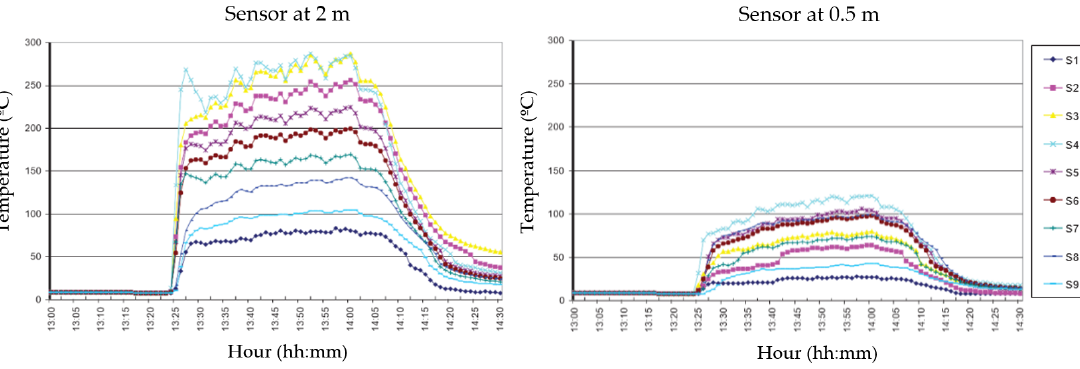
Figure 12. Evolution of the temperature along the drift at different heights; scenario 3.